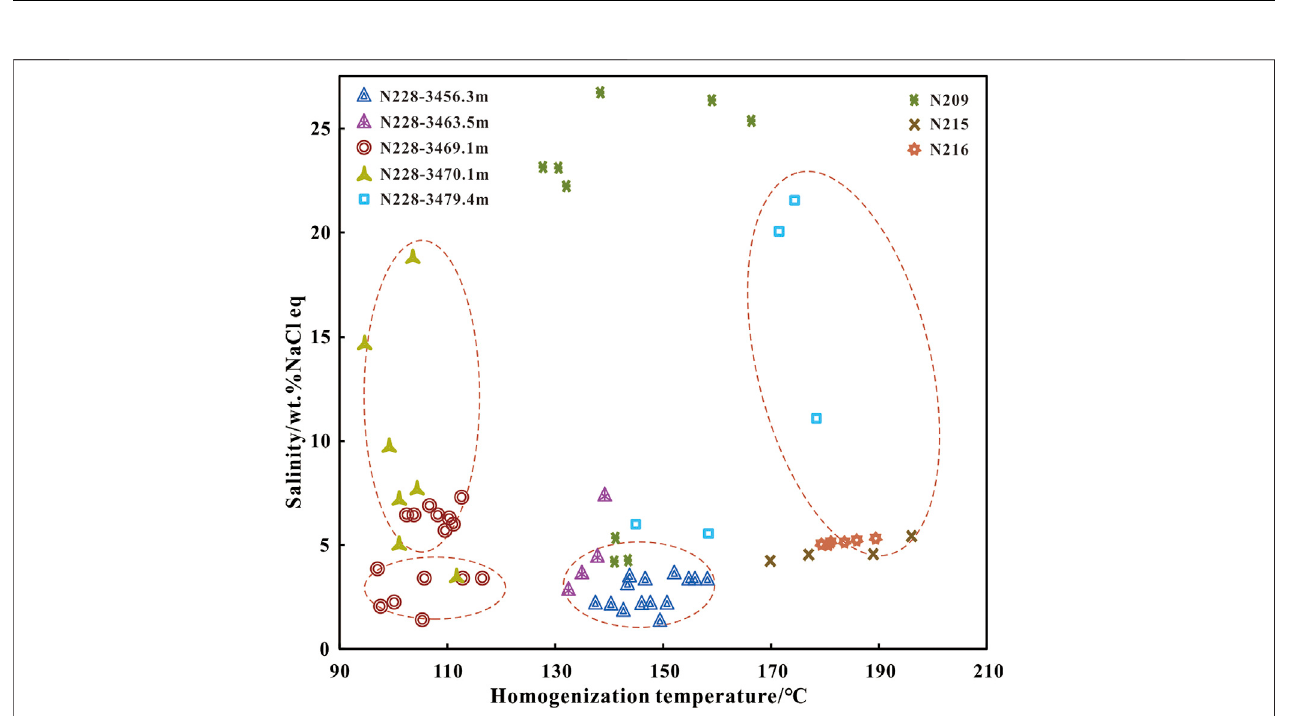
FIGURE12| ScatterdiagramofTh-salinityofFItrappedinwellsN228,N216,N209,andN215,anddataofwellsN209,N215,andN216collectedbyGong(2019) and Liang et al. (2021).